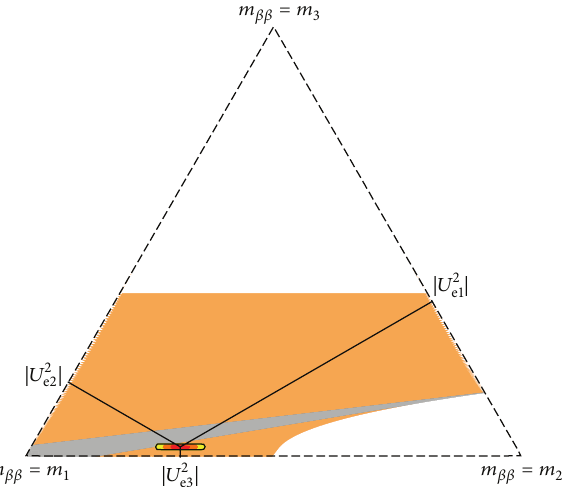
Figure 22: Representation of 𝑚 min 𝛽𝛽 in the unitarity triangle. The internal point in the middle of the small colored bar is identified by the constraints from the oscillation parameters. The colored regions correspond to 1𝜎 (red), 2𝜎 (orange), and 3𝜎 (yellow). The distance from a side represents the size of the corresponding mixing element | . The inner shaded regions of the triangle enclose the areas |𝑈 2 e 𝑖 where 𝑚 min 𝛽𝛽 = 0 for a lightest neutrino mass that can vary from 10 −5 eV to the value which corresponds to a cosmological mass Σ = 0.14 eV (orange, 90% CL current bound) and Σ = 0.06 eV (gray, for purpose of